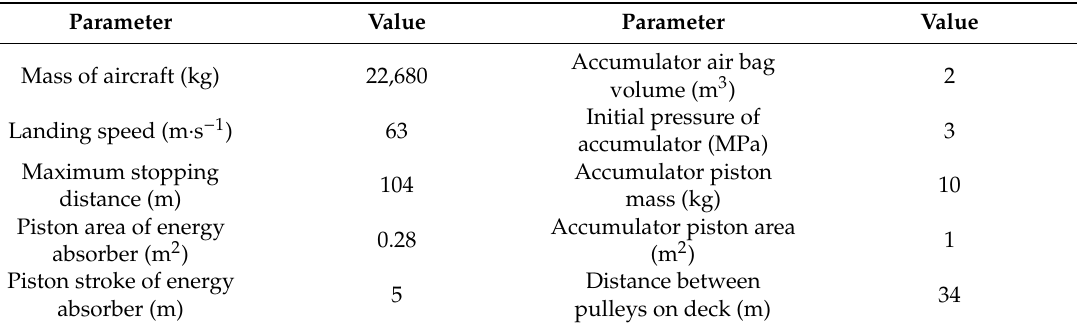
Table 1. Parameters of the carrier aircraft and landing gear.